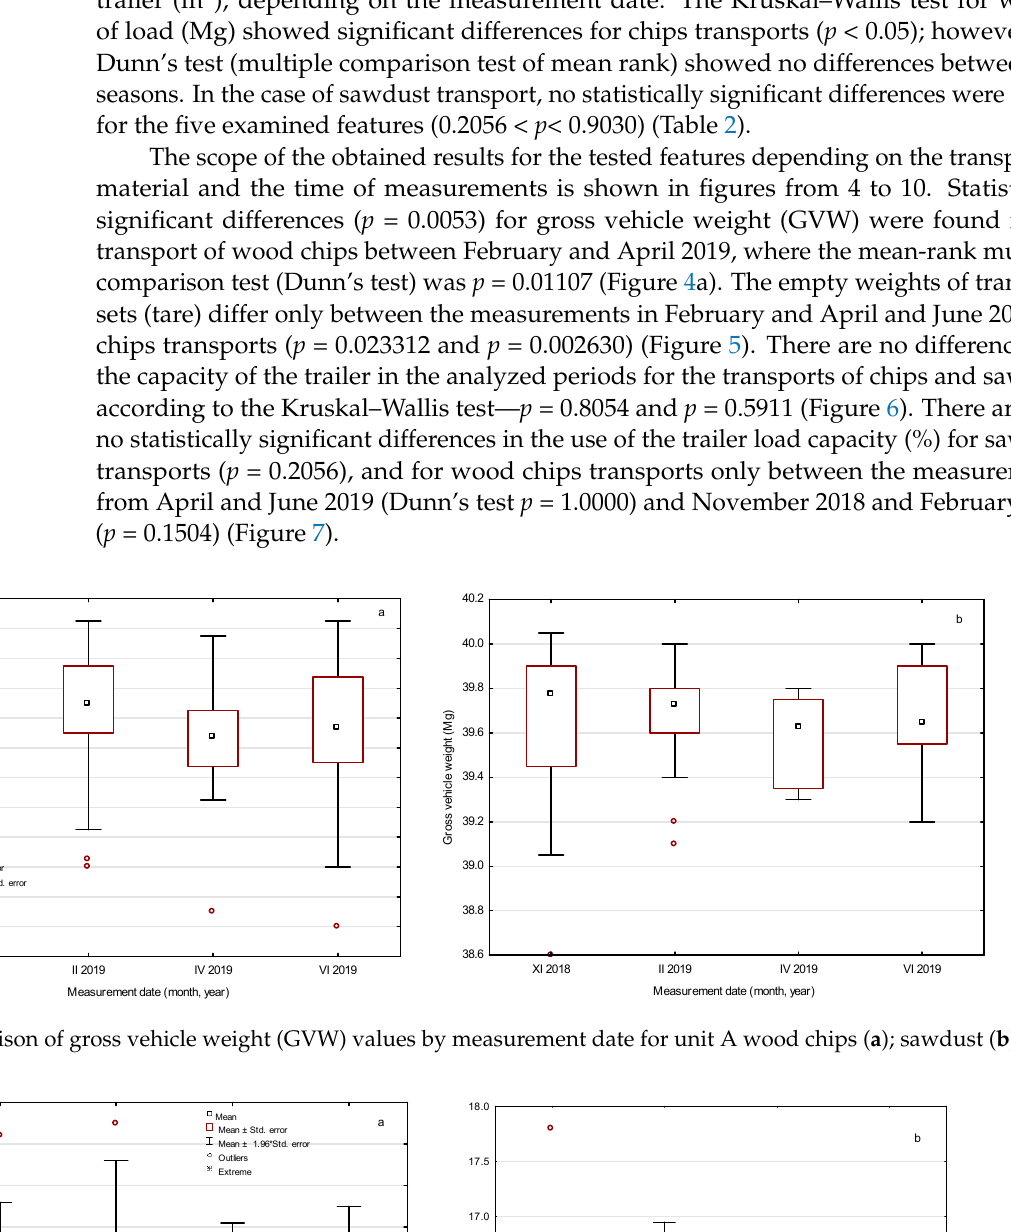
Mean Mean ± Std. error Mean ± 1.96*Std. error Outliers Extreme Figure 6. Comparison of semi-trailer capacity values by measurement date for unit A wood chips ( a ); sawdust ( b ). XI 2018 b Figure 7. Comparison usage of semi-trailers capacities by measurement date for unit A wood chips ( a ); sawdust ( b ). The volume of the transported material in solid cubic meters (m 3 ) and bulk volume of the load (bulk m 3 ) (Figure 8b) of sawdust differs only in II from IV 2019 ( p = 0.0314) and November 2018 from IV 2019 ( p = 0.0036), and for wood chips in all dates, except for the comparison of IV with VI 2019 (Figure 8a). There were no statistically significant differ- ences in the weight of the load (Mg) between the measurement dates for the transport of wood chips and sawdust ( p = 0.6005) (Figure 9). Bulk density (Mg/m 3 ) values do not differ only between the transports of wood chips in April and June 2019 ( p = 1.0000) and No- vember 2018 and February 2019 ( p = 0.0664) (Figure 10a). In the transport of sawdust, differences in bulk density were found only between transports in November 2018 and April 2019 ( p = 0.0444) (Figure 10b).